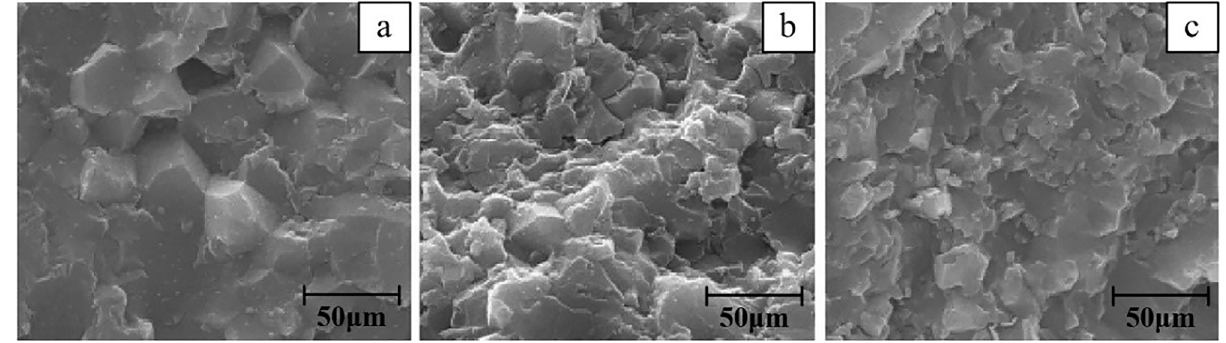
Figure 2: Scanning electron micrographs of fracture surface with different content of nano-Al 2 O 3 [12]. (a) 80 wt% nano-Al 2 O 3 , (b) 70 wt% nano-Al 2 O 3 , (c) 60 wt% nano-Al 2 O 3